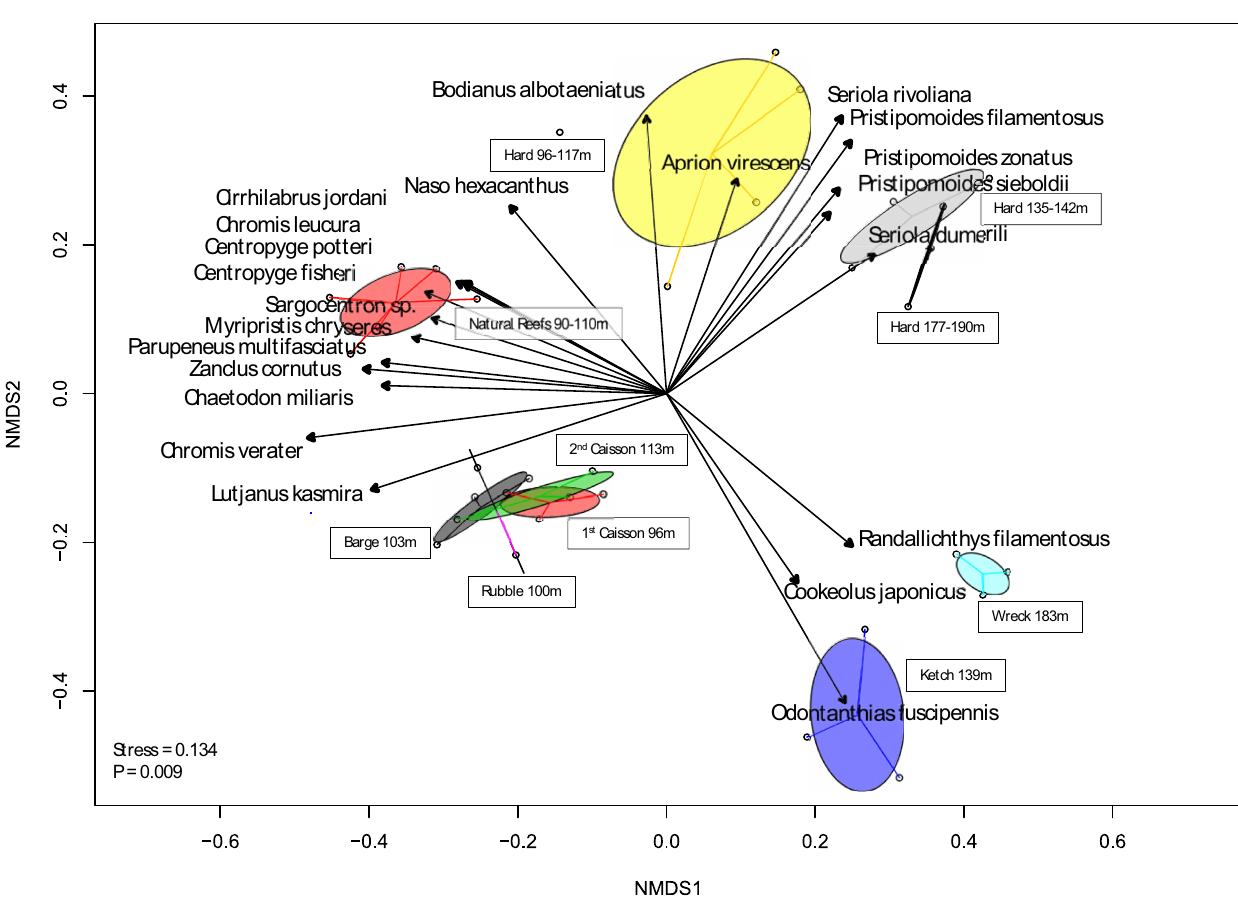
Fig 4. Horizontal comparison of artificial and natural substrates. nMDS analysis comparing all six artificial features with naturally-occurring habitat types at comparable depths. Observations are grouped (colored ellipses) by feature (artificial substrates) or depth (natural substrates). Loadings of individual species are shown (dark gray) for species with very significant (p < 0.01)